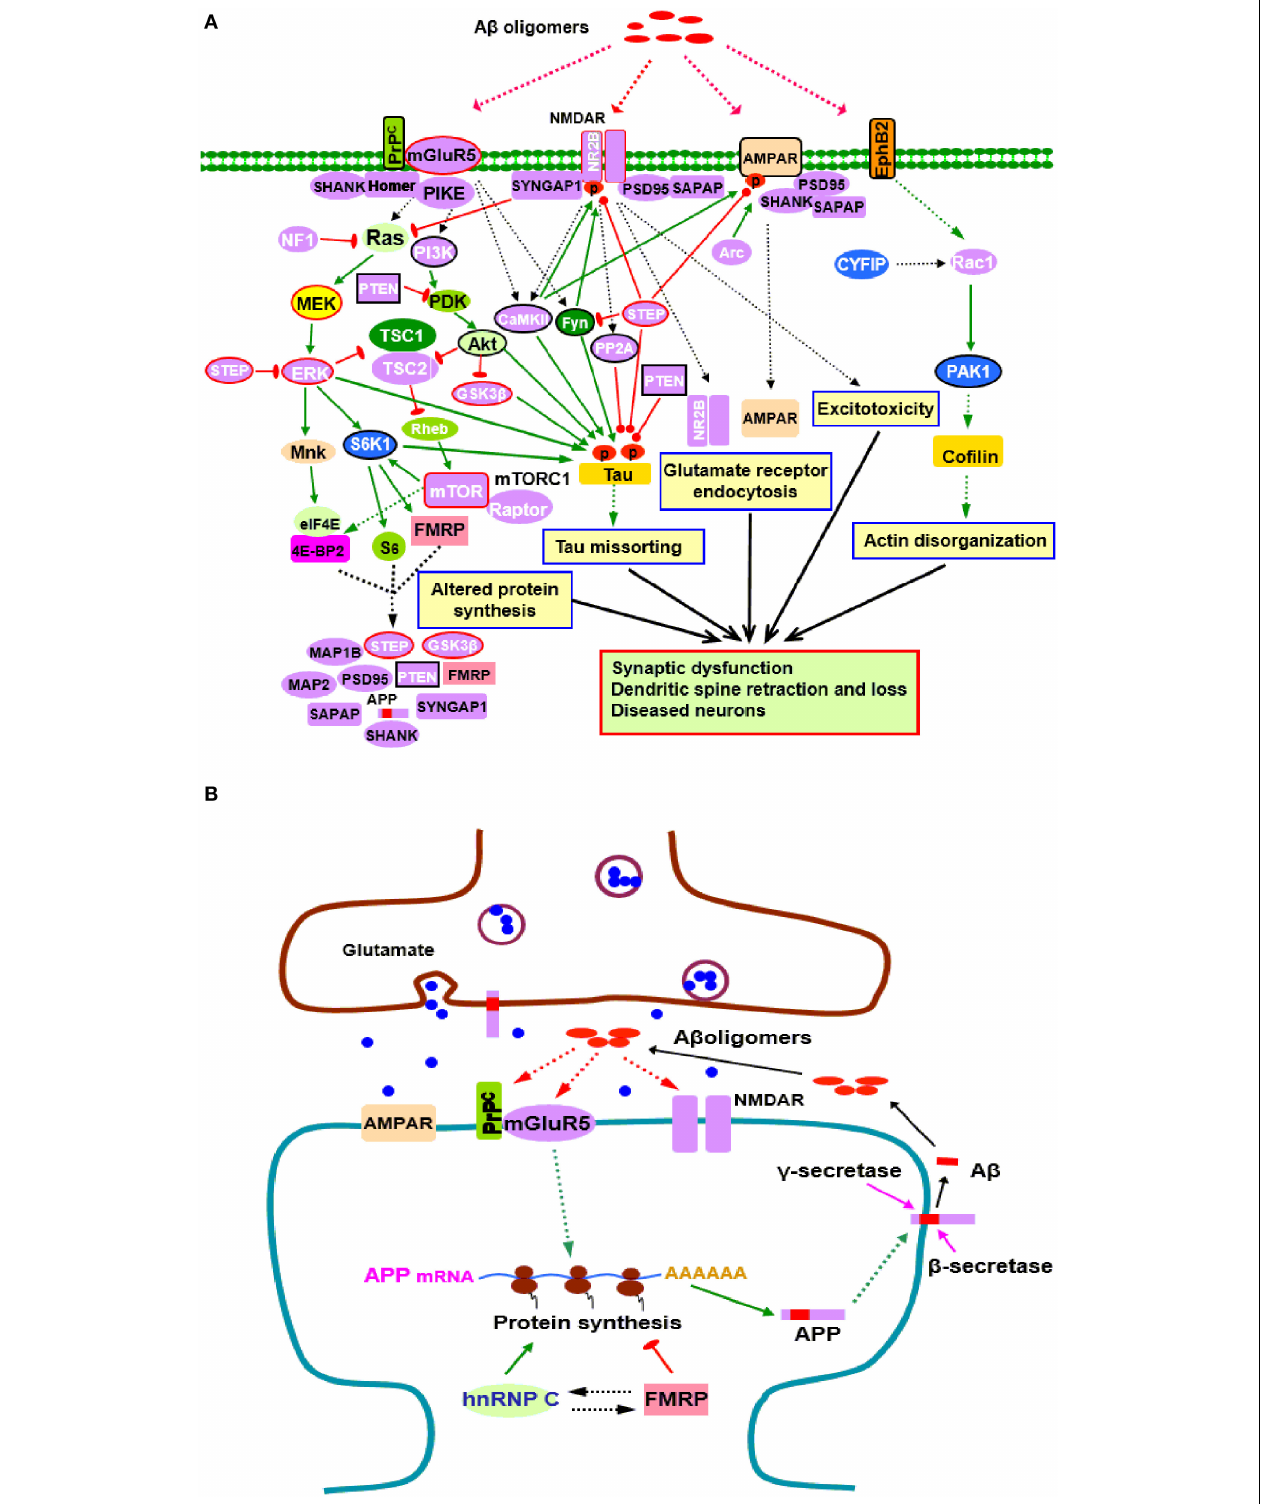
FIGURE 1 | Potential roles of FMRP in the pathogenesis of AD. (A) FMRP might be involved in oligomeric A β induced neurotoxicity. At pathological concentrations, A β oligomers may interact with multiple neuronal synaptic